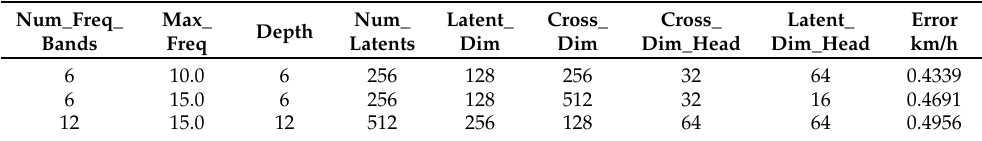
Table A4. Summary of the best hyper-parameters of the